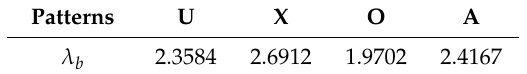
Table 3. Critical geometrical parameter λ b ( S / h = 80, a GPL /b GPL = 4, b GPL /t GPL = 10 3 , W GPL = 0.5%). Patterns